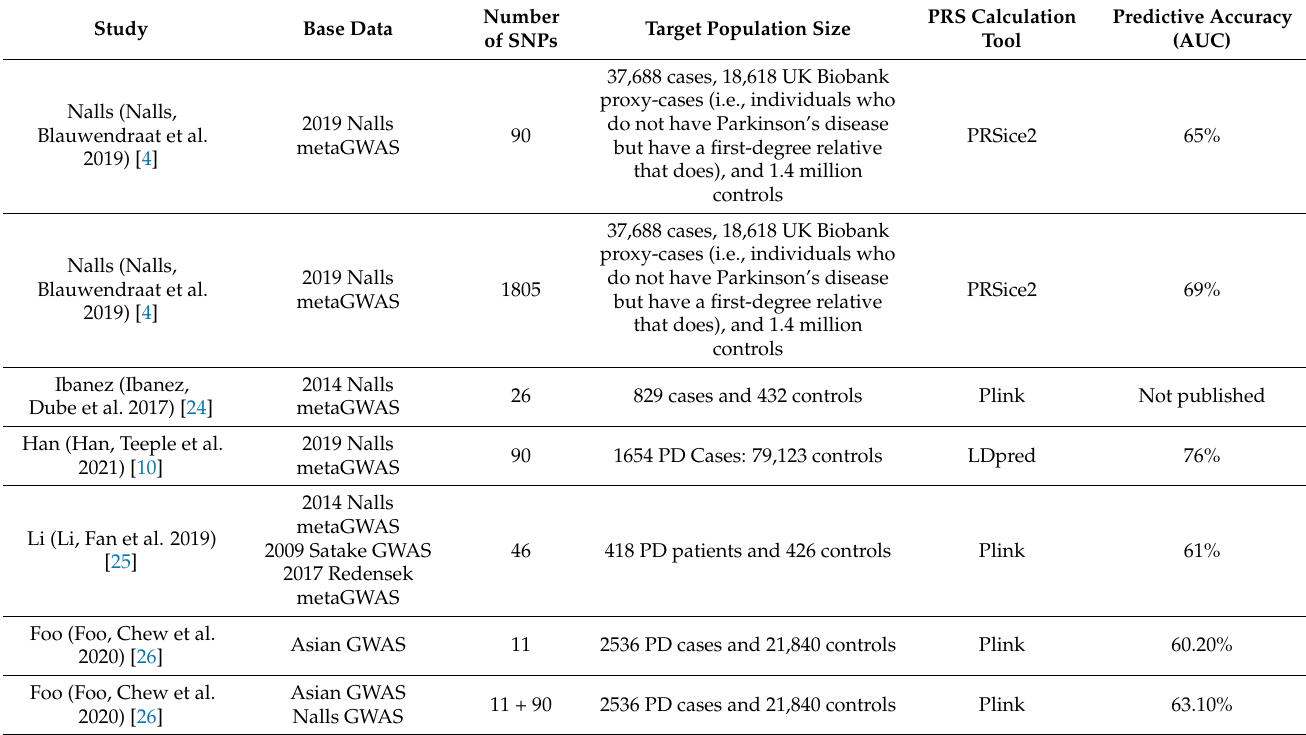
Table 1. Summary of general PRS studies that have performed PD risk